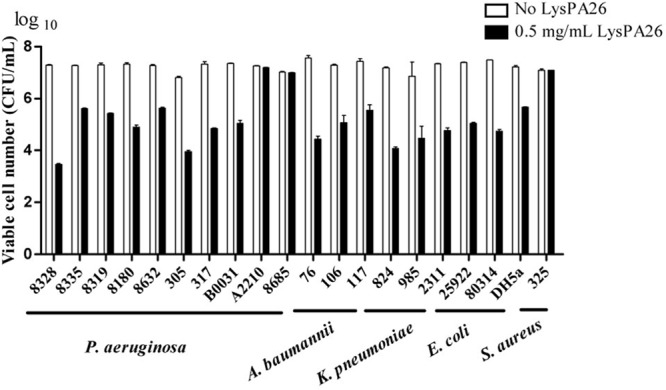
The antimicrobial spectrum of the LysPA26. Bacteria, including both Gram-negative and Gram-positive bacteria, were examined. For all the challenged isolates, 0.5 mg/ml LysPA26 was added into the bacteria suspension after 30 min incubation at 37°C. The antibacterial activity was expressed as the decrease in viable bacterial numbers. Error bars represent the standard deviations of three independent assays.